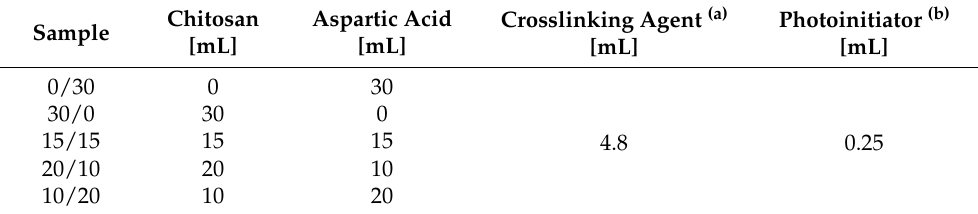
Table 1. Compositions of chitosan/poly(aspartic acid)-based hydrogels.